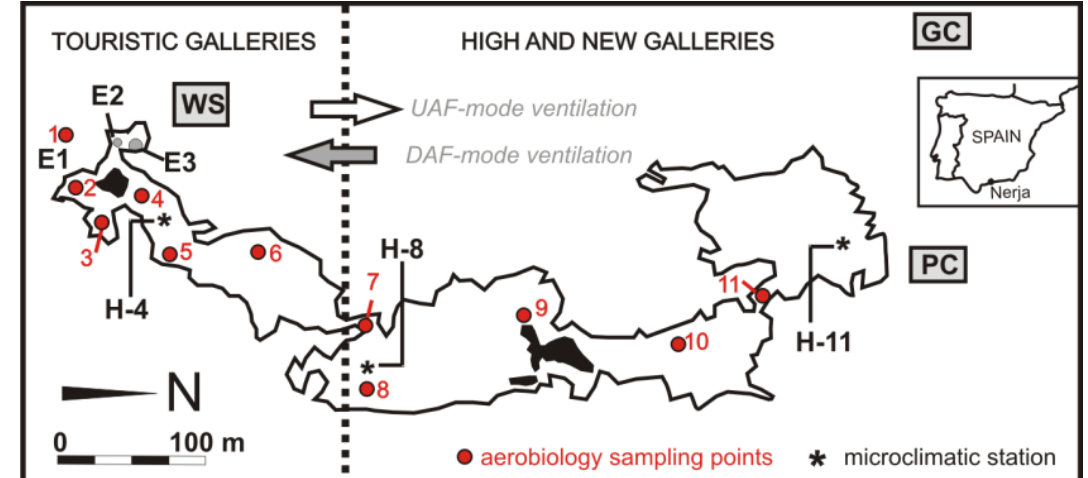
Figure 1. Cave map and location of the aerobiology sampling points and microclimatic stations. 1: Cave Exterior, 2: Entrance Hall, 3: Nativity Hall, 4: Cascade Hall, 5: Ghosts Hall, 6: Cataclysm Hall, 7: Kitchen Hall, 8: Heracles Hall, 9: Immensity Hall, 10: Lance Hall, 11: Mountain Hall. PC: Pintada Cave, GC: non accessible cave from surface, WS: weather station, E1: tourist entrance, E2 and E3: sinkholes. Location of PC, GC, and WS is approximate.